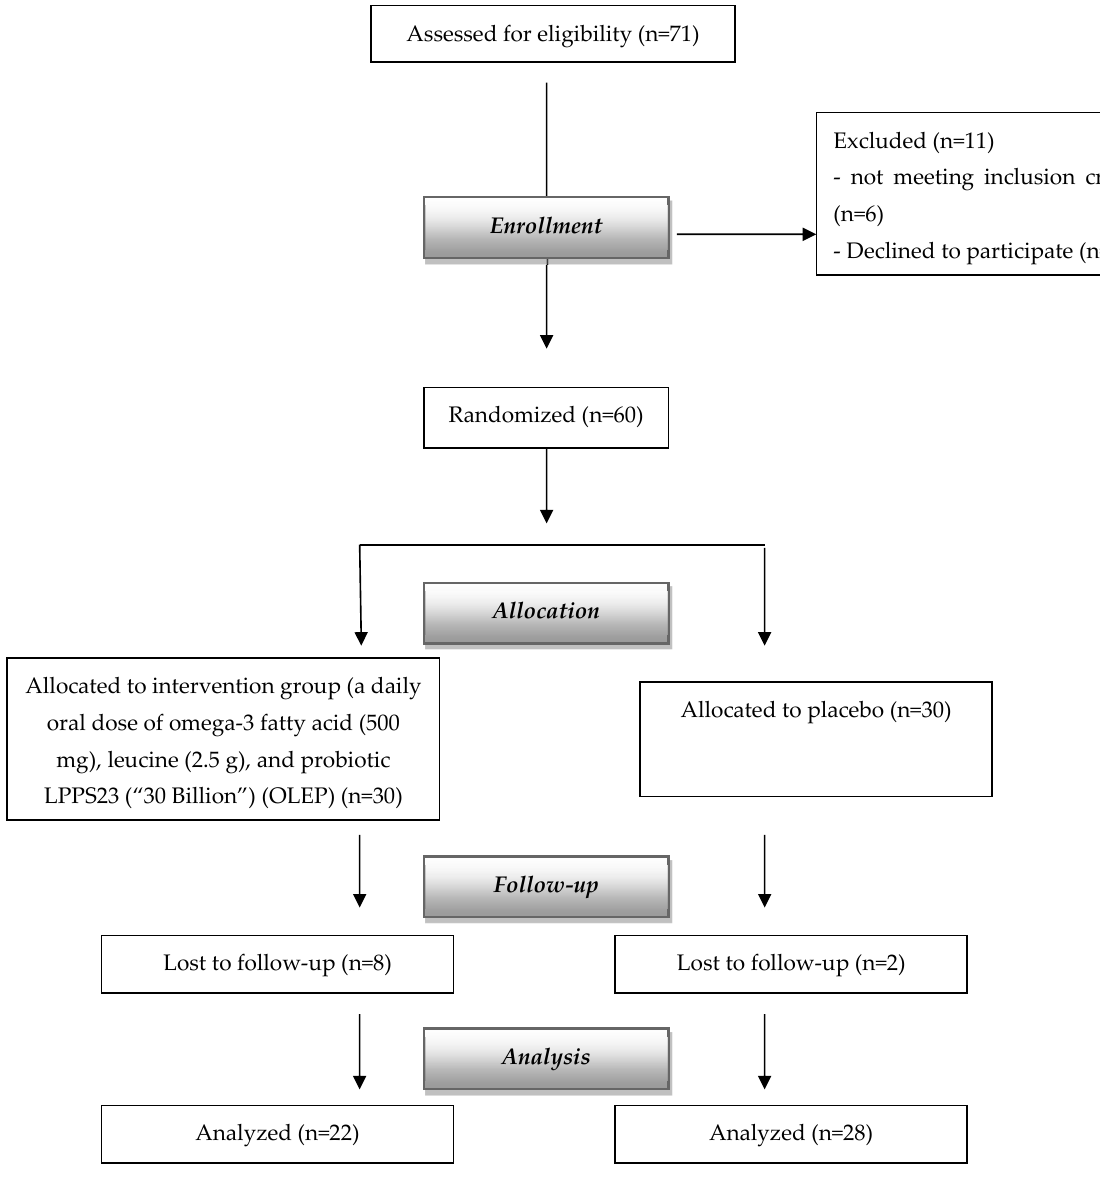
Figure 2. Flowchart of the study. Table 1. The baseline clinical characteristics of patients between the intervention and placebo groups.